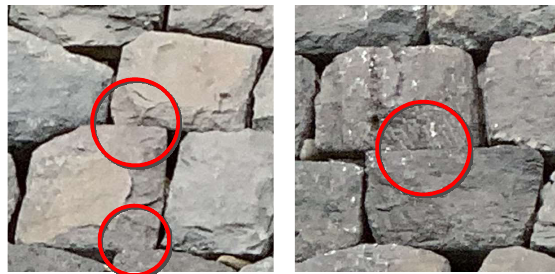
Figure 2. Examples of wall stones with unclear